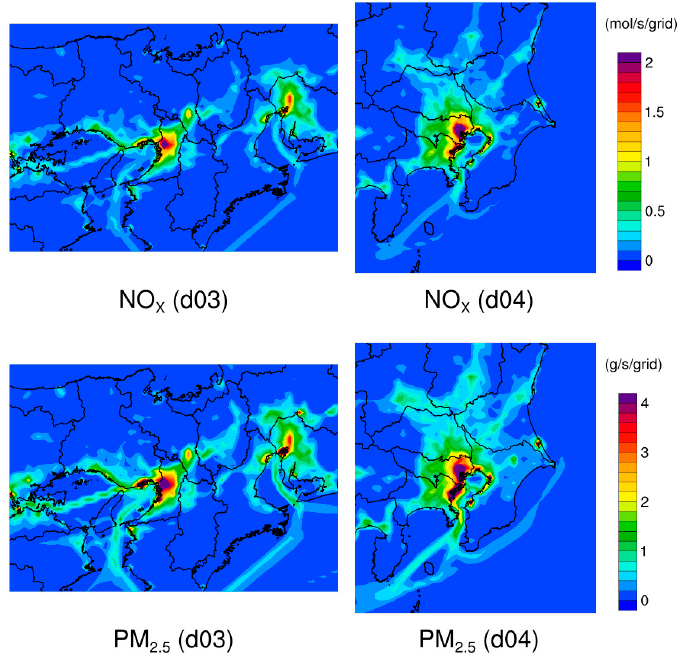
Figure 3. Horizontal distributions of annual mean NO X and primary PM 2.5 emissions in d03 and d04 for fiscal year 2013.